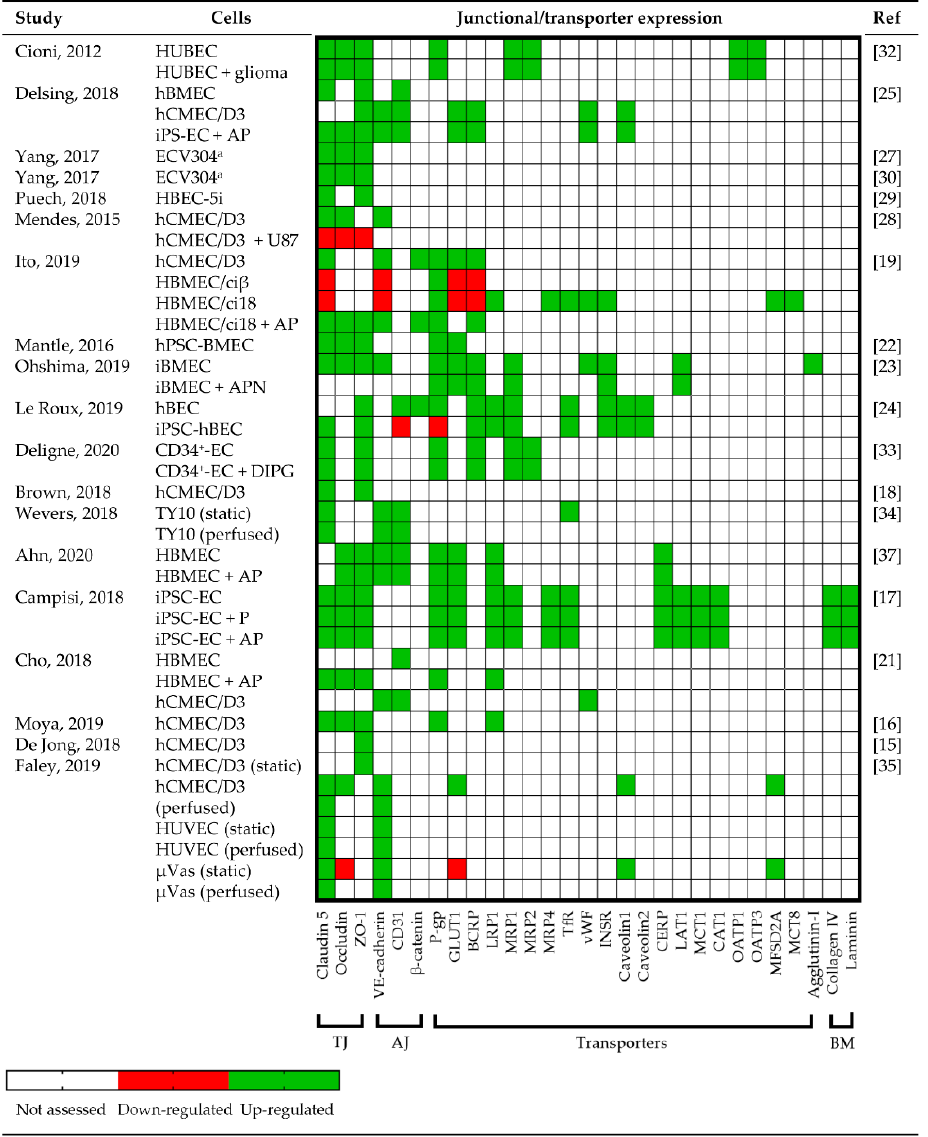
Figure 4. Junctional, adherens and transporter expression. A heat map of the expression of up- (green) and down- (red) regulated expression as assessed by immunofluorescent staining and/or real-time quantitative reverse transcription polymerase chain reaction. Proteins/genes that were not assessed are denoted in white. a ECV304 was later identified to be a human urinary bladder carcinoma cell line, presenting many endothelial cell (EC) phenotypic characteristics [30]. µ Vas, microvascular; A, astrocyte; AJ, adherens junction; BCRP, breast cancer resistance protein; BM, basement membrane; CAT1, cationic amino acid transporter 1; CERP, cholesterol efflux regulatory protein; DIPG, diffuse intrinsic pontine glioma; EC, endothelial cell; GLUT1, glucose transporter 1; hBEC/hBMEC/hCMEC/ HUBEC, human brain/cerebral (microvascular) endothelial cell; HUVEC, human umbilical vein endothelial cell; iBMEC, induced brain microvascular endothelial